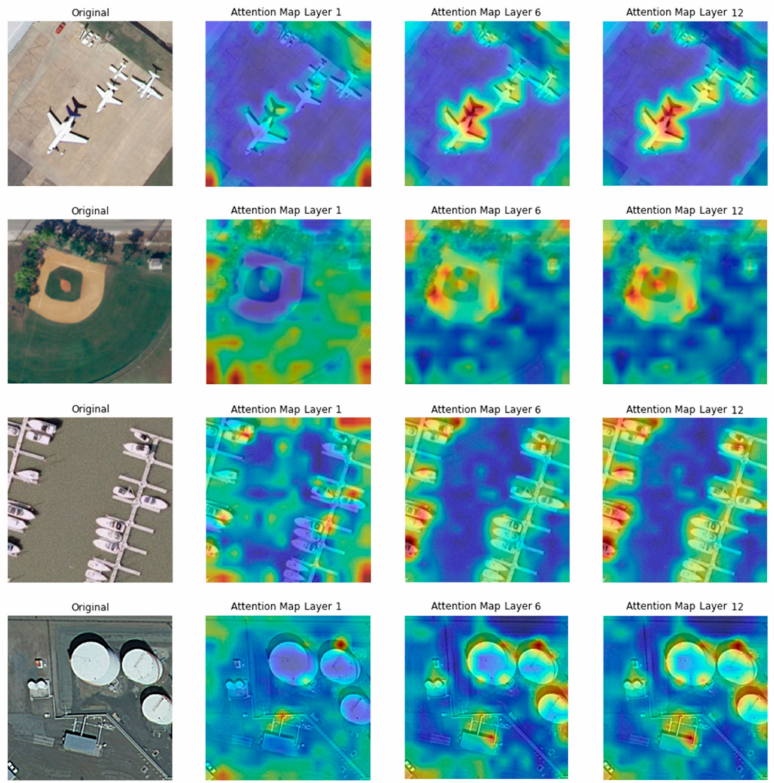
Figure 6. The class attention maps resulted from different encoder’s layers for the Merced dataset.